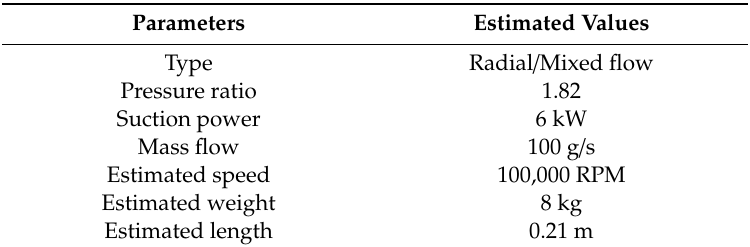
Table 2. Estimated design parameters for compressor.